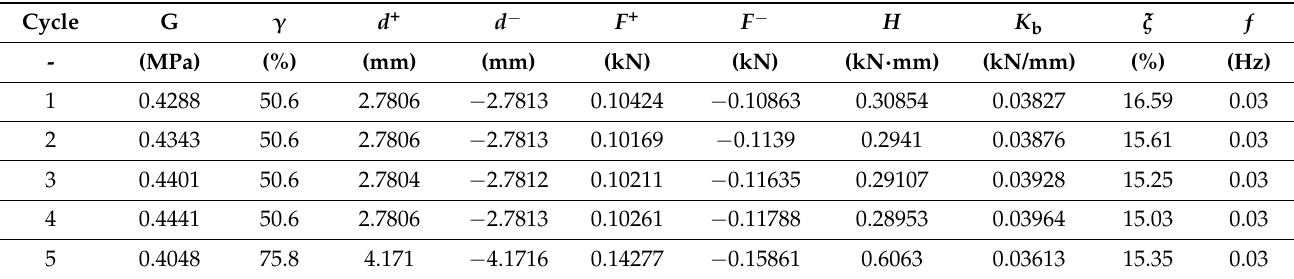
Table 1. Result data for